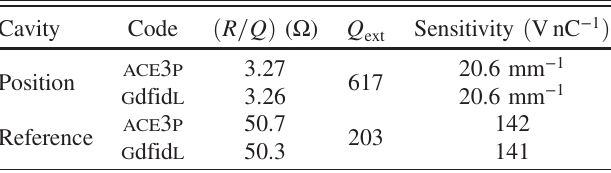
TABLE III. Calculation of the predicted sensitivities of the reference cavity to charge and the position cavity to beam charge and position.